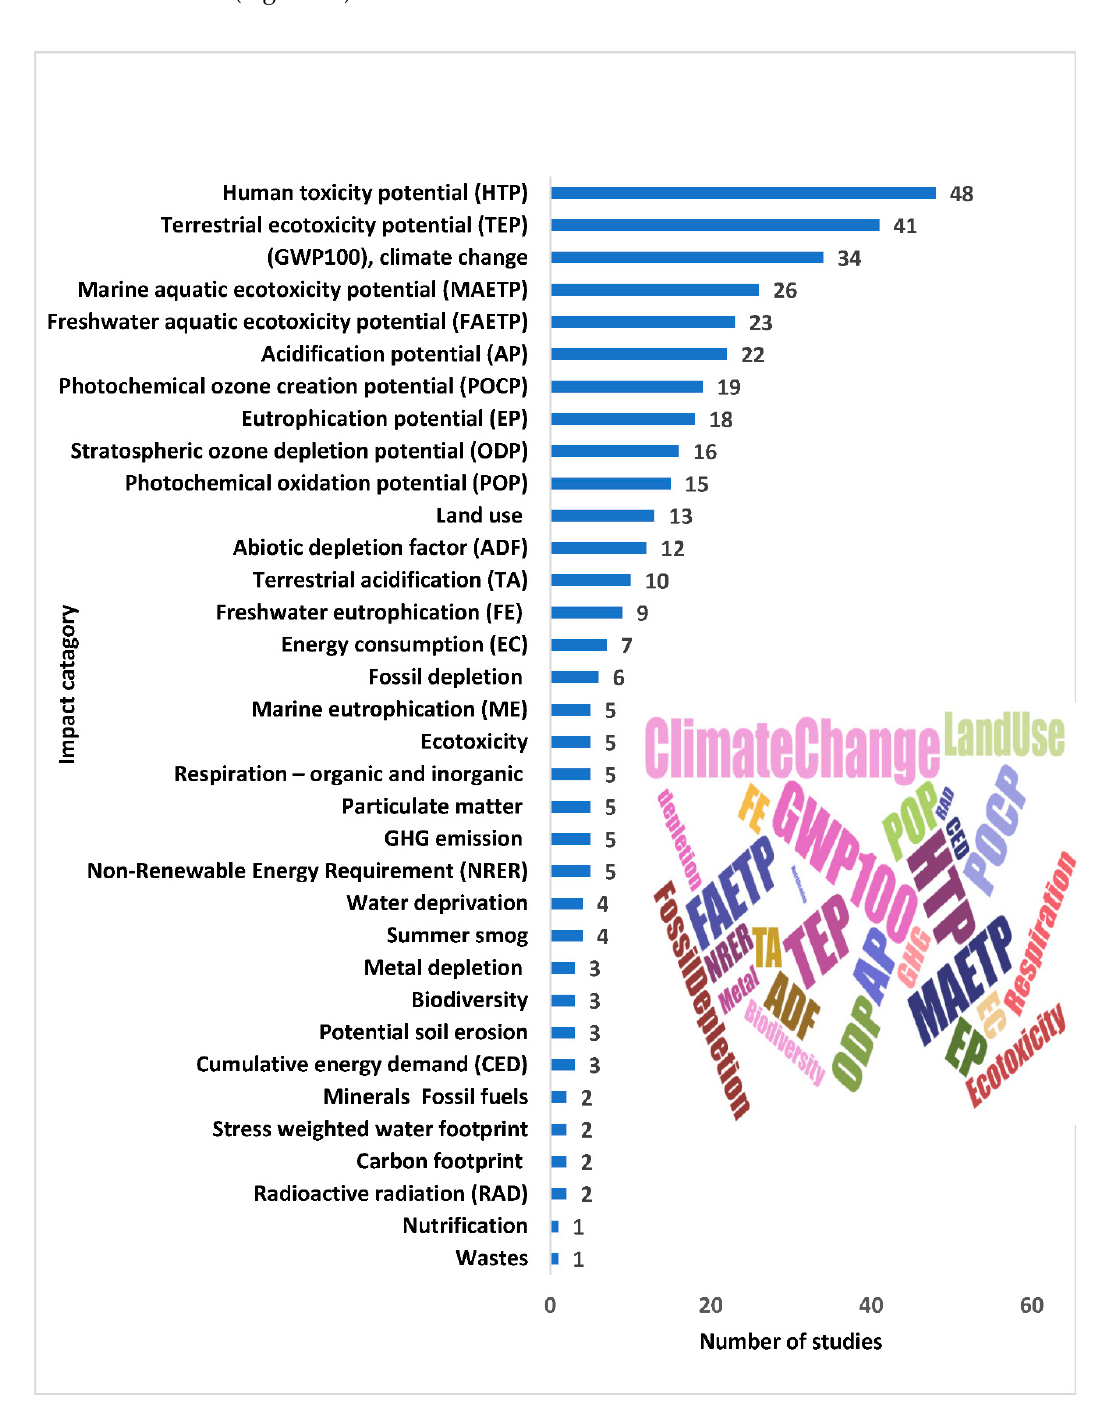
Figure 16. Illustration of LCIA impact categories from the literature (characterization).